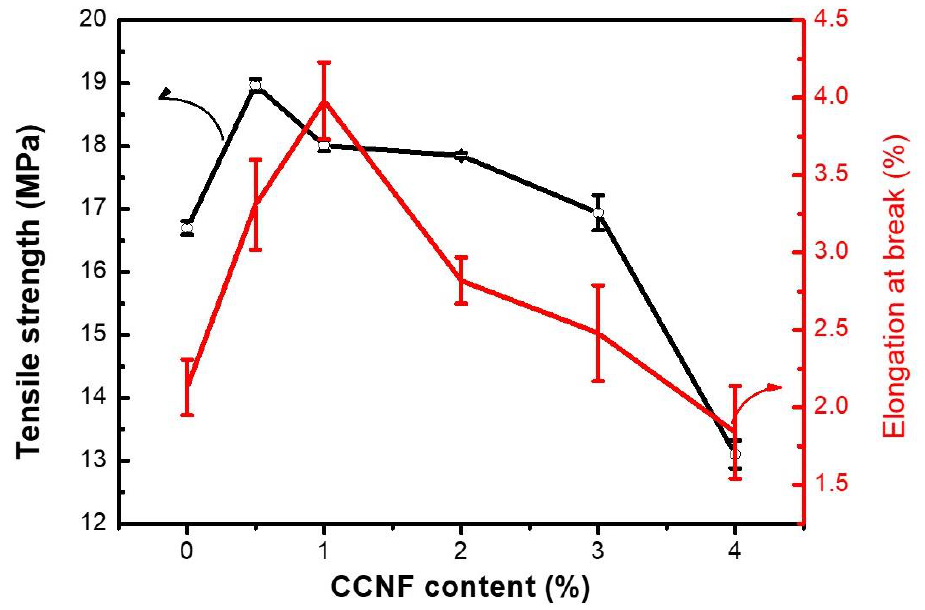
Figure 7. Tensile properties of CS/CCNF films with different CCNF contents.